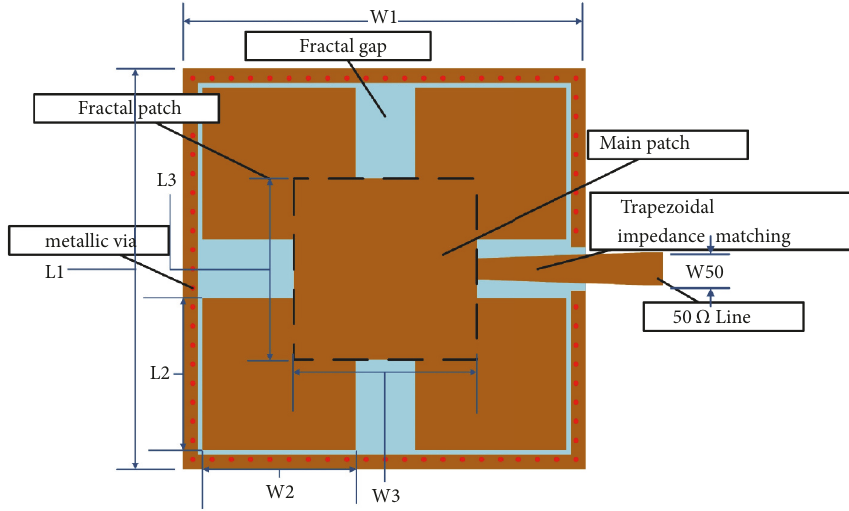
Figure 1: Whole mode cavity structure